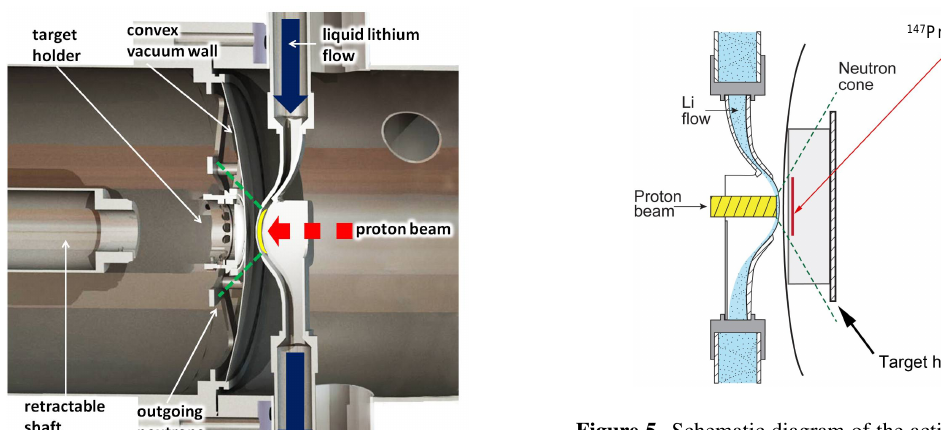
Figure 5. Schematic diagram of the activation setup: the 147 Pm target in an airtight Al holder is located just downstream of the curved wall (thick solid line) separating the vacuum of the LiLiT chamber and that of the activation